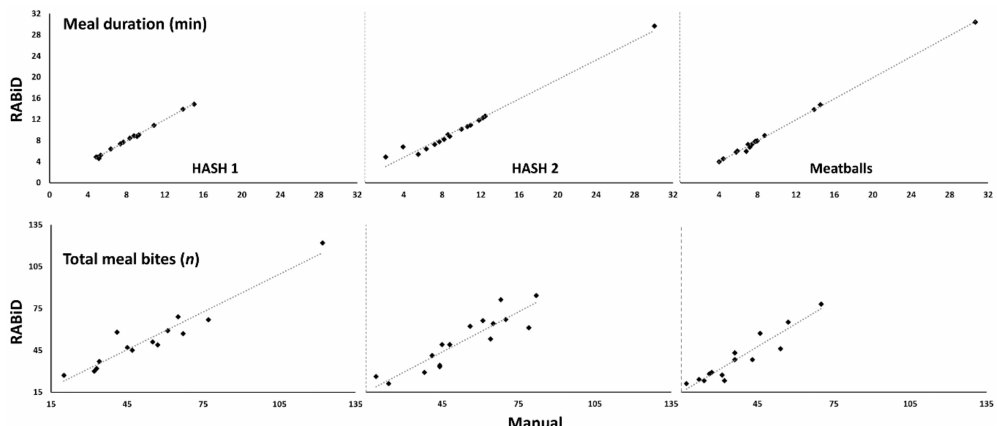
Figure 6. Scatter plots of the meal durations and total meal bites for all the analyzed meals in the behavioral dataset. Very high agreement is observed between manual and RABiD measures in all cases.